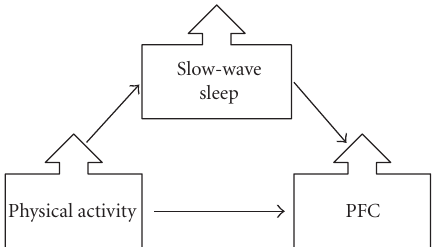
Figure 5: Model illustrating slow-wave sleep as mediating the relationship between physical activity and PFC function. With an increase in physical activity, there is an increase in slow-wave sleep, leading to improved PFC function and in turn improved executive control